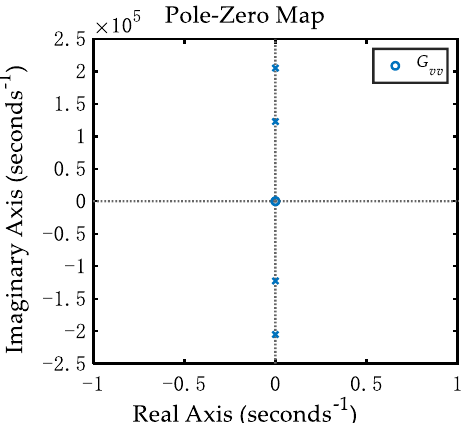
Figure 5. Open loop system pole-zero map of G vv ( s ).